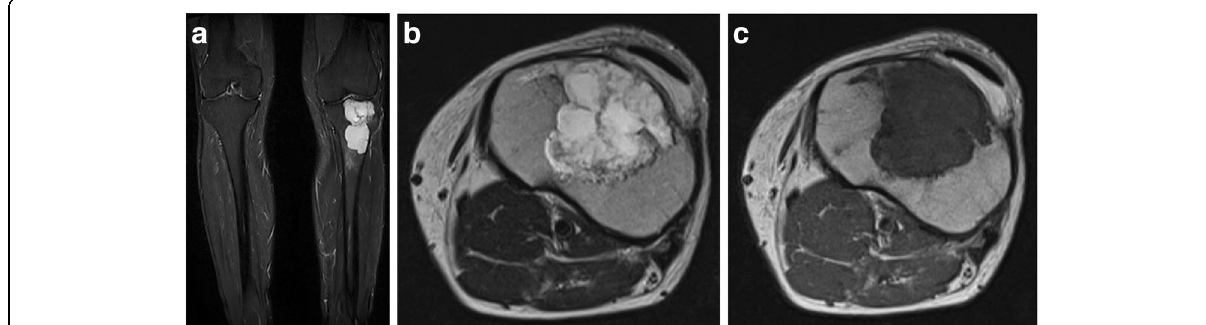
Fig. 17 a – c MRI showed a multiloculated lesion with high T2, and Short-Tau Inversion Recovery (STIR) signals. The lesion is predominately a low T1 with mildly hyperintense patchy areas, which suggested intralesional haemorrhage. No fluid/fluid